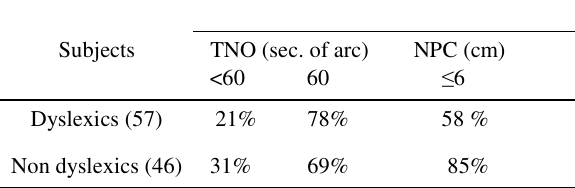
Subjects TNO (sec. of